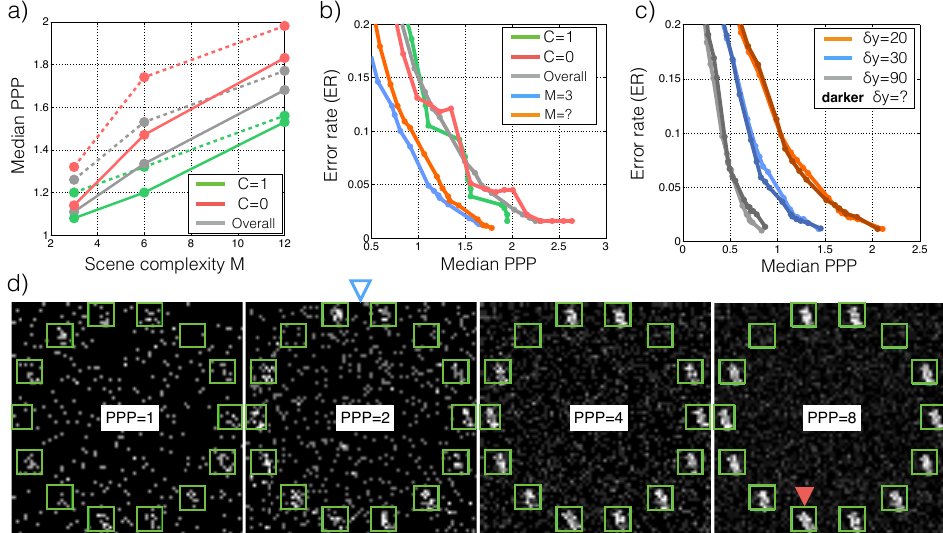
Figure 6. Characteristics of the search algorithm. ( a ) Median PPP required to achieve 5% error rate as a function of scene complexity M . Solid/dashed lines represent search problems where the complexity is known/unknown in advance. ( b ) ER vs . PPP tradeoff for various conditions. The first three legends corresond to target-present (C = 1), target-absent (C = 0) and their average for M = 12. The last two corresponds to a simpler image containing three bars with the complexity known ( M = 3) and unknown ( M = ?) in advance. ( c ) ER vs . PPP tradeoff for different appearance y T y D differences δ y = between the target and the distractor. Darker lines denote the cases where | − | the difference is unknown before hand. ( d ) Examples of lowlight search stimuli as a function of PPP. L = 14, M = 12, δ y = 20 ◦ , target-present (C = 1, location indicated by red arrow, same for every PPP). The photon-counting sensors receive inputs from within the green windows. With known complexity the algorithm achieves a 1% error rate with a median PPP of 2 (blue hollow